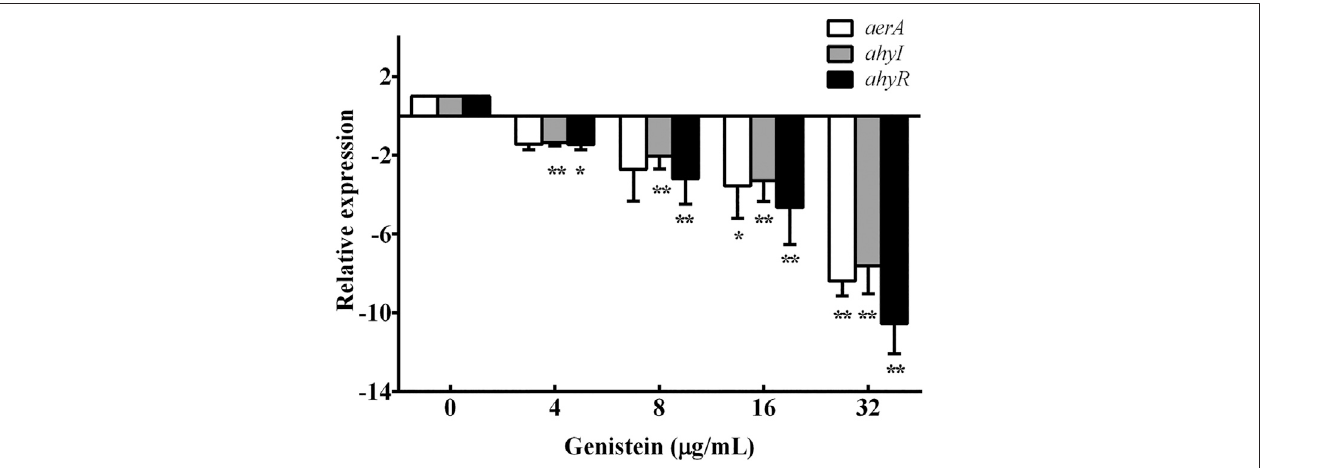
FIGURE5| ProtectiveeffectsofgenisteinonaerolysinmediatedA549cellinjury.Cellinjuryinducedbyaerolysinwasevaluatedbylive/deadstainingassayandLDH release assay. For live/dead staining assay, live cells were stained with green, while dead were red. (A) , cells without any treatment; (B) , cells treated with drug-free supernatant; (C) ,cellstreatedwithsupernatantobtainedfrombacterialcultureplus32 μ g/mlgenistein; (D) ,LDHreleaseofA549cellstreatedwithbacterialsupernatants plus indicated concentrations of genistein, LDH assay was performed in triplicate, data were mean value ± SD. * p < 0.05 and ** p < 0.01.